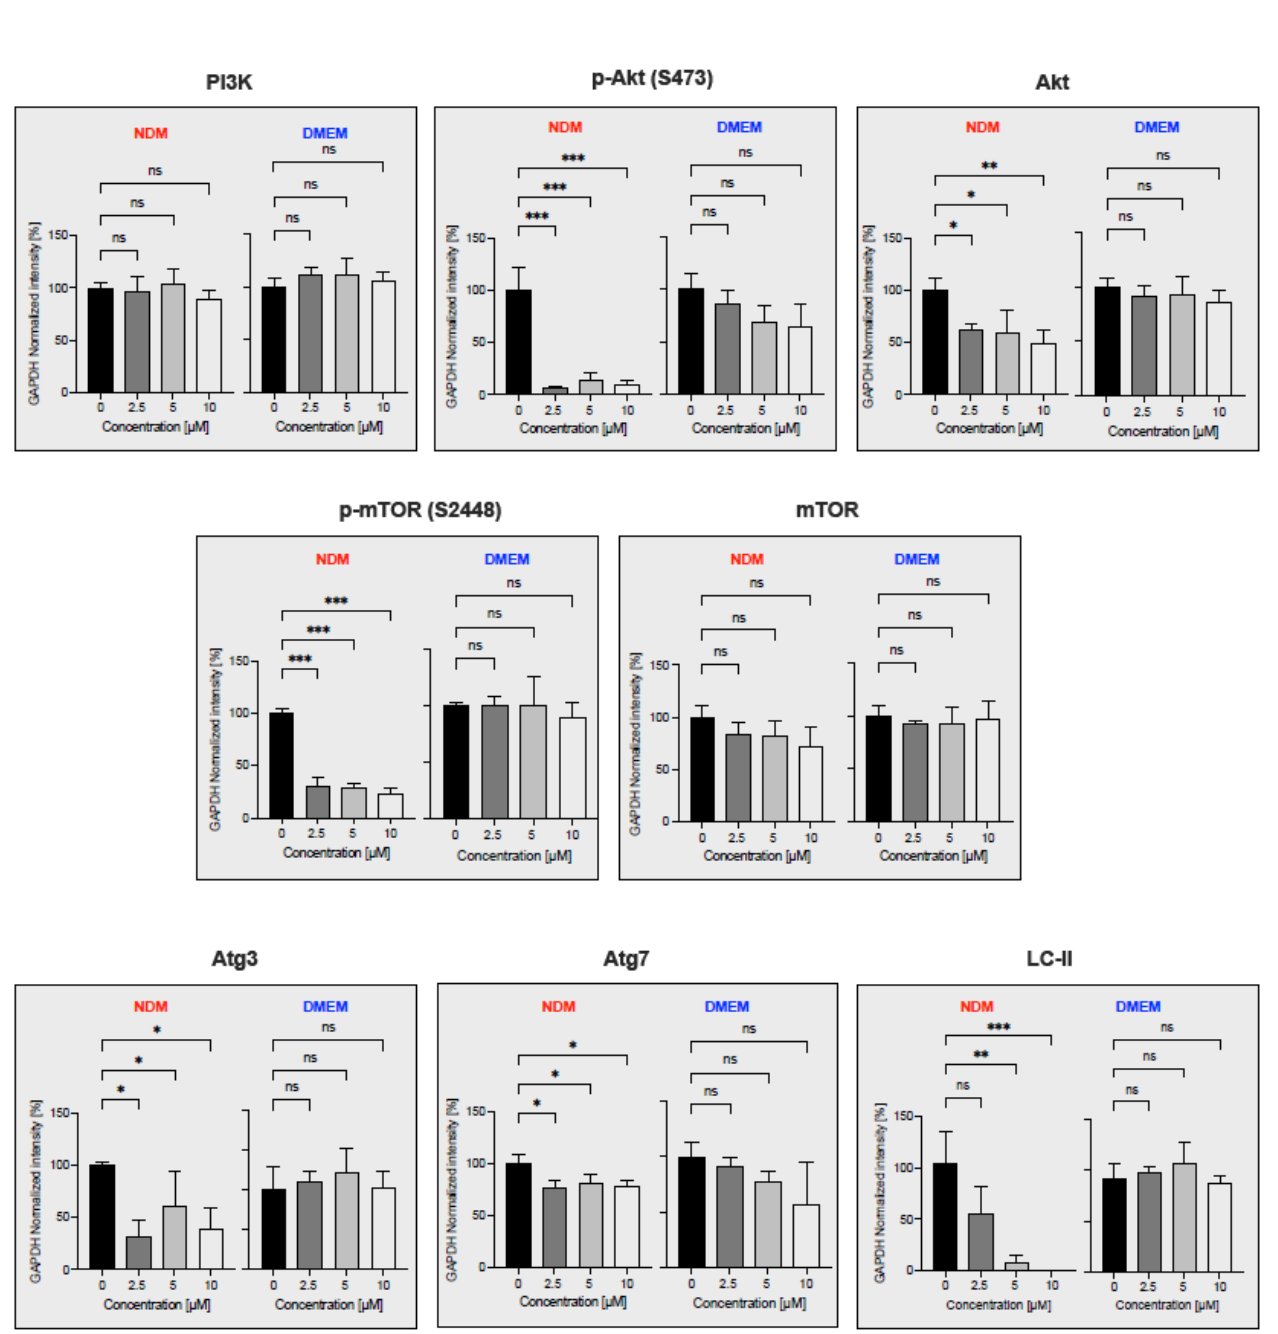
Figure 8. The percentage of GAPDH normalized intensity of myrtucommulone A ( 2 ) on protein related to the PI3K/Akt/mTOR and autophagy signaling pathway under NDM and DMEM. The statistical significance was calculated using one-way ANOVA of three independent experimental results using GraphPad Prism 9. * p < 0.05; ** p < 0.01; *** p < 0.001 indicates a significant difference from the